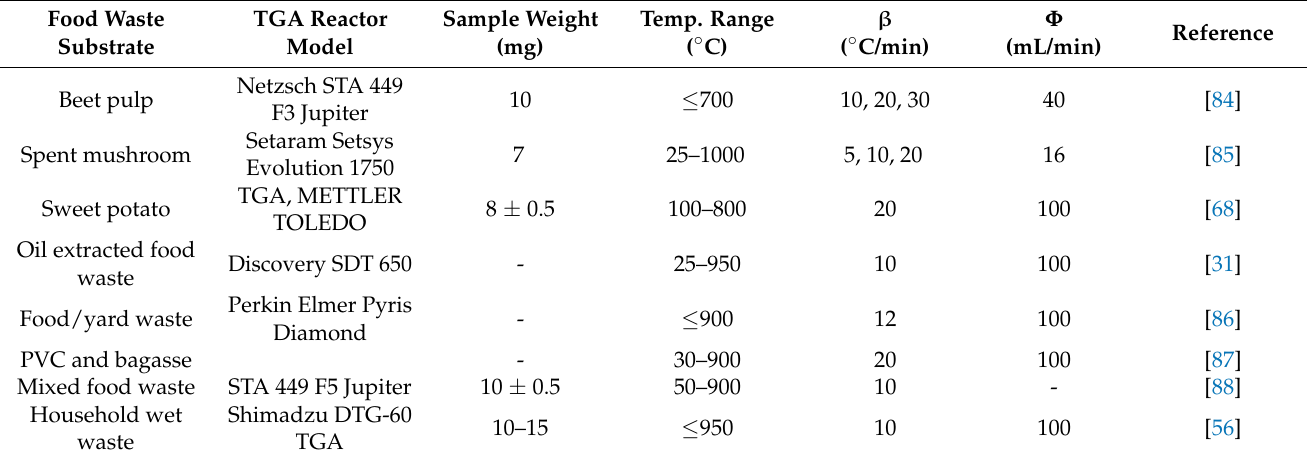
Table 4. TGA parameters reported for kinetic studies of combustion of hydrochar for different food